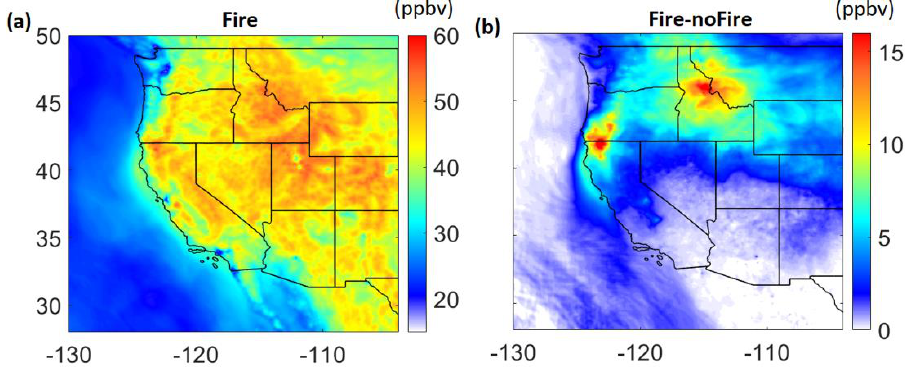
Figure 17. Spatial distribution of average ( a ) surface ozone mixing ratios in ppbv from the ‘Fire’ simulation and ( b ) difference in surface ozone mixing ratios in ppbv between the ‘Fire’ and ‘noFire’ simulations for the first half of September 2017.